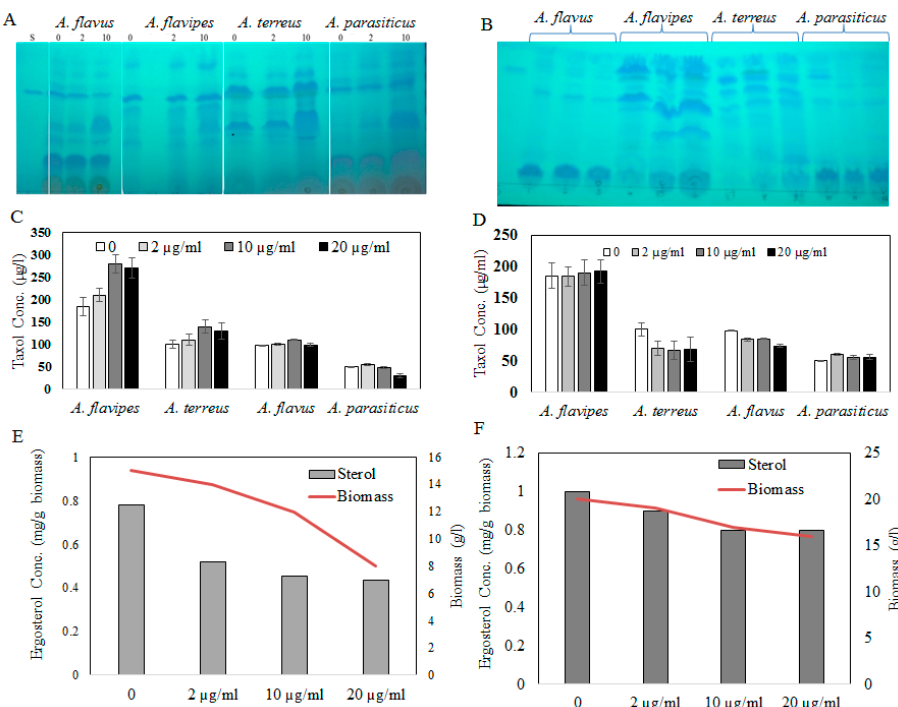
Figure 2. ( A ) TLC chromatogram of Taxol by the fungal isolates in response to fluconazole (0, 2, and 10 µ g / mL), and ( B ) AgNO 3 concentrations (0, 2, and 10 µ g / mL). Taxol concentration in response to fluconazole ( C ) and AgNO 3 ( D ) by the tested fungal isolates by HPLC. Ergosterol concentration of A. flavipes ( E ) and A. terreus ( F ) in response to fluconazole addition.